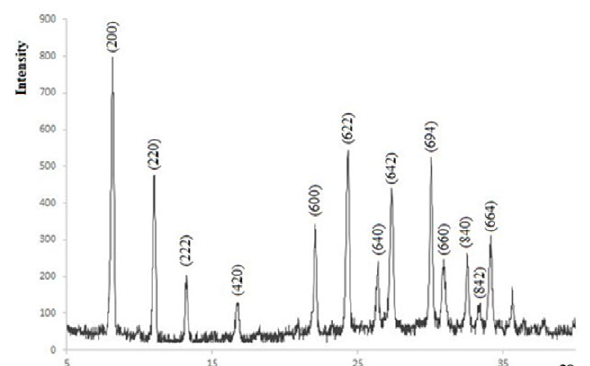
Fig. 2. X-Ray Diffraction (XRD) patterns of zeolite Fig. 2. X‐Ray Diffraction (XRD) patterns of zeolite